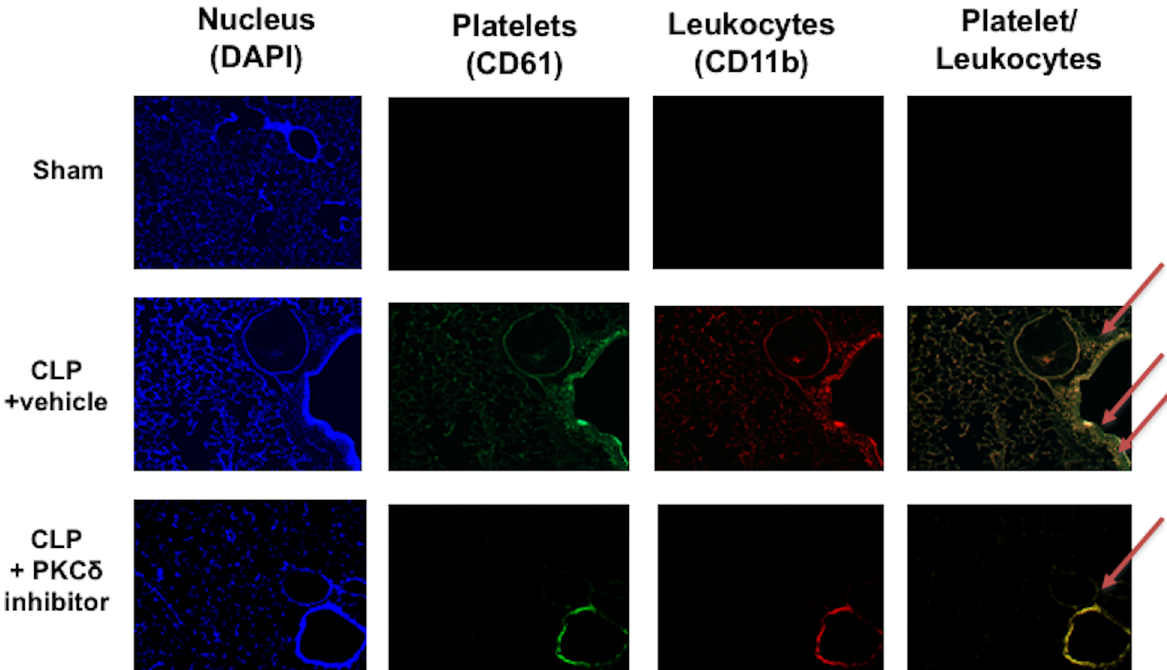
Fig 6. Platelet-leukocyte co-localization in the lungs. Lung tissue were co-stained with FITC-conjugated anti-CD61 (platelets) and PE- conjugated anti-CD11b (leukocytes) in Sham and CLP plus vehicle rats. Nuclei were labelled with DAPI. The first column shows nuclei staining, the second column platelet sequestration in the lung. The third column shows leukocyte infiltration in the lung tissue, while the last column shows both platelet and leukocyte content (red arrows). Images are representative of 4 independent experiments.